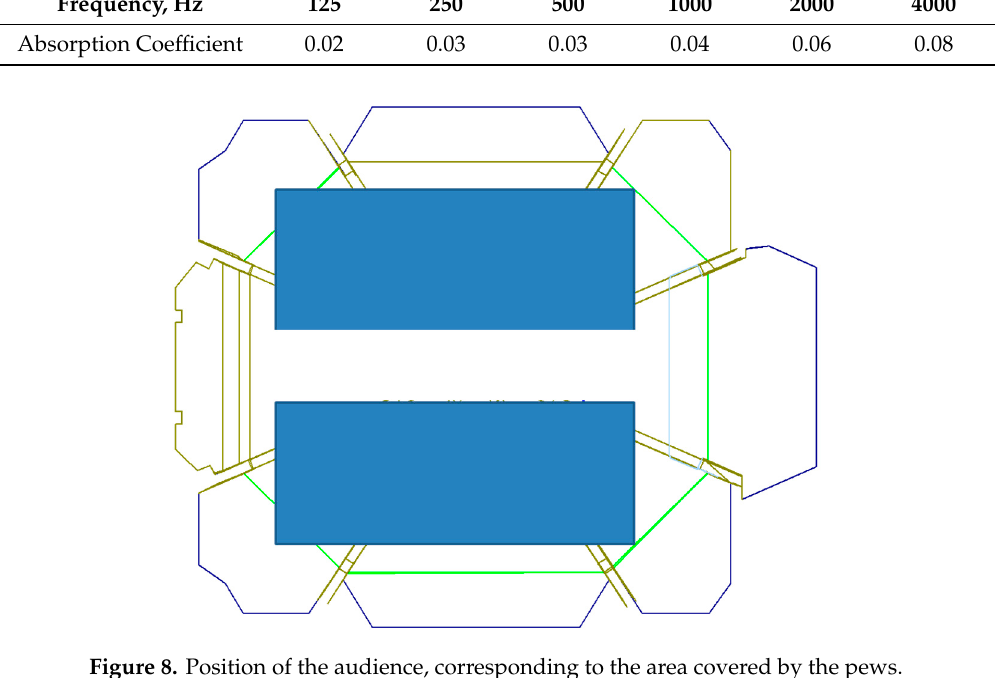
Figure 8. Position of the audience, corresponding to the area covered by the pews.